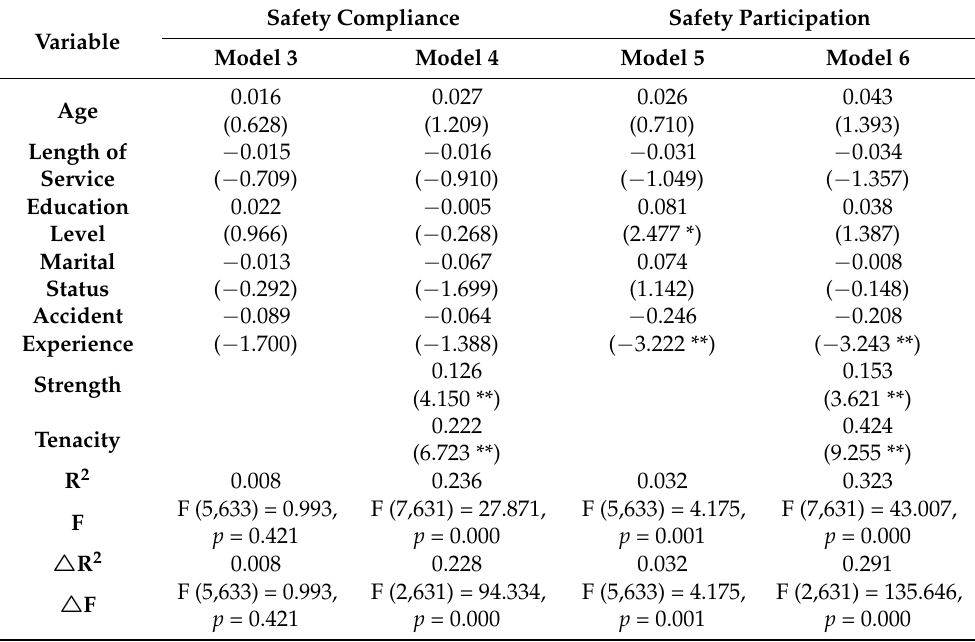
Table 10. Regression analysis of the two dimensions of resilience on the two dimensions of safety behavior (N =